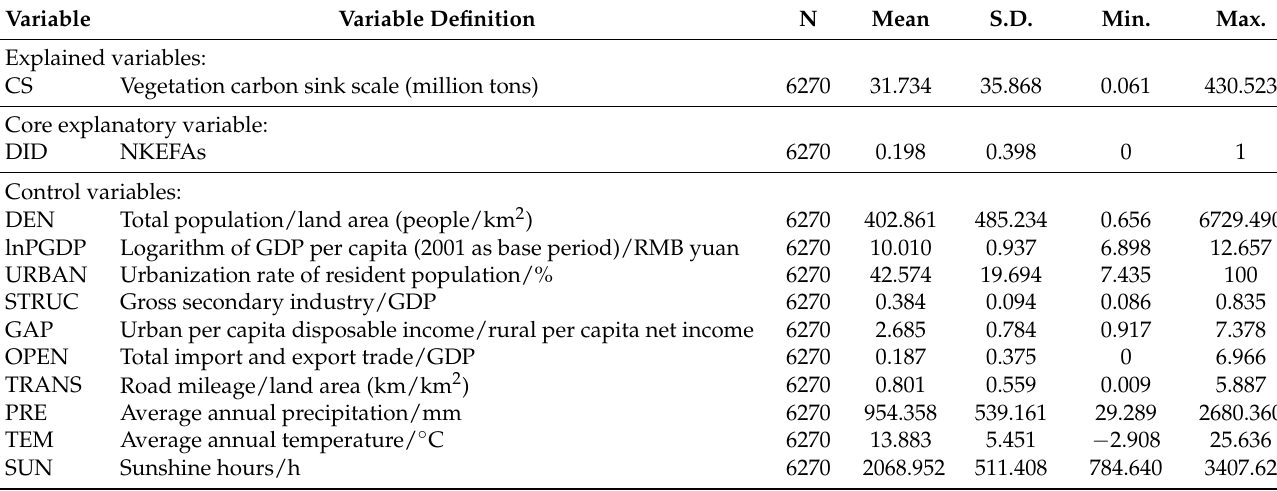
Table 1. Descriptive statistics of the variables.